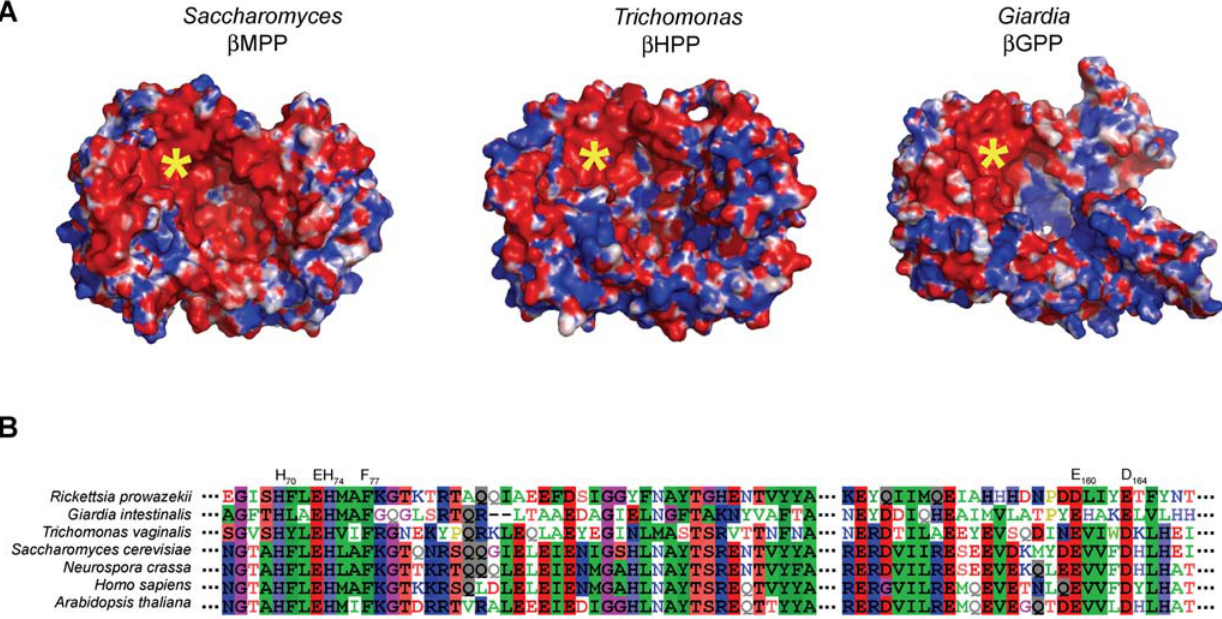
Figure 4. Comparative distribution of charge polarity between mitochondrial, hydrogenosomal and mitosomal peptidases. ( A ) Predicted charge polarity distribution of the b HPP subunit and b GPP based on the known structure and charge distribution of the Saccharomyces cerevisiae b MPP subunit [10]. Red and blue colours denote negative and positive charge ( 6 5 kT/e where kT is thermal energy and e is unit charge), respectively, whereas white denote relatively non-polar regions. The yellow asterisk marks the Zn-binding region in the active site of the enzyme (shown in b). The negative charges are distributed evenly in the cavity of b MPP while in the cavity of b GPP the negative charges are concentrated mainly around the active site. The MODELLER program [29] version 9.2 was used to build 3-D models of a HPP, b HPP and b GPP. The electrostatic properties of the model were evaluated using APBS version 0.5.1 [33]. ( B ) Alignment of key segments where negatively charged residues of b MPP are located and known to interact with the substrate. Numbered residues are those of yeast b MPP. E 160 and D 164 make a salt bridge with substrate residue R-2 (P 2 ) and F 77 interacts with P 1 9 which is also often a F residue. H 70 -X-X-E 73 -H 74 is the conserved motif of the active site.